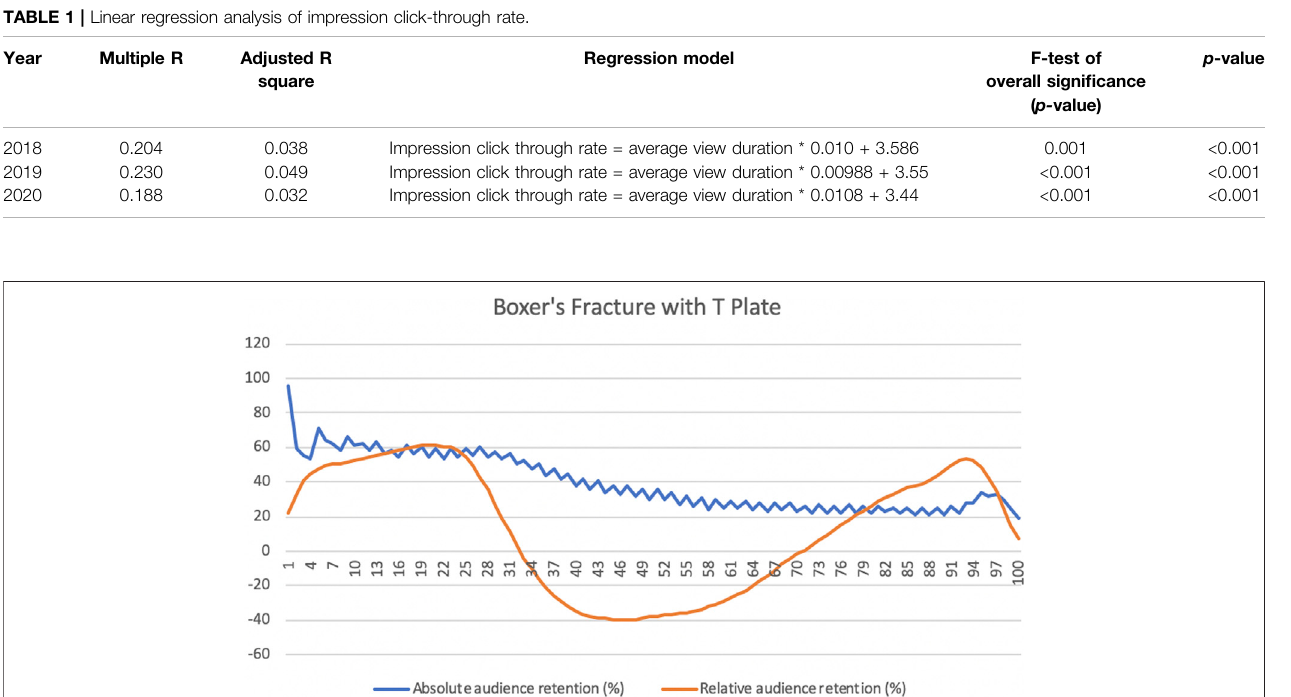
Frontiers in Applied Mathematics and Statistics |